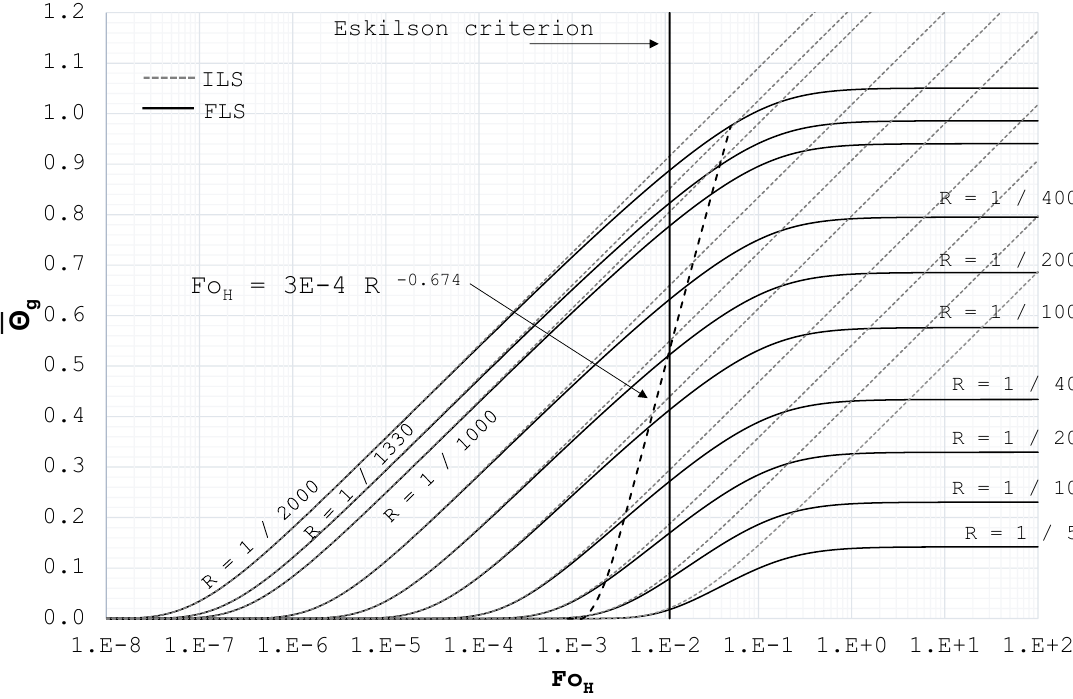
Figure 6. FLS solution: the average dimensionless temperature, Θ g , evaluated through the FLS model (solid lines) and the ILS model (dashed lines). The bold vertical line represents the Eskilson criterion, i.e., Fo H = 1/90. The bold dashed line represents the limit beyond which the relative deviation between FLS and ILS models is higher than